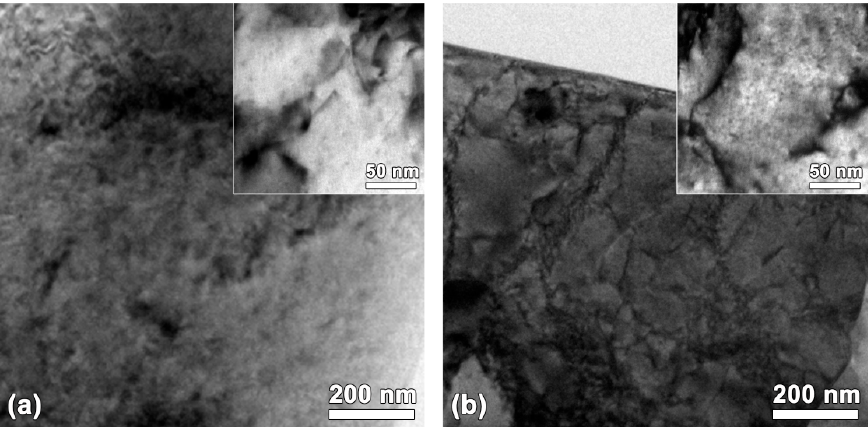
Figure 6. Typical BF images recorded from ( a ) sample A ′ and ( b ) sample B ′ with magnified BF images showing the effect of the amount of precipitation on the dislocation density after the hot-rolling process.